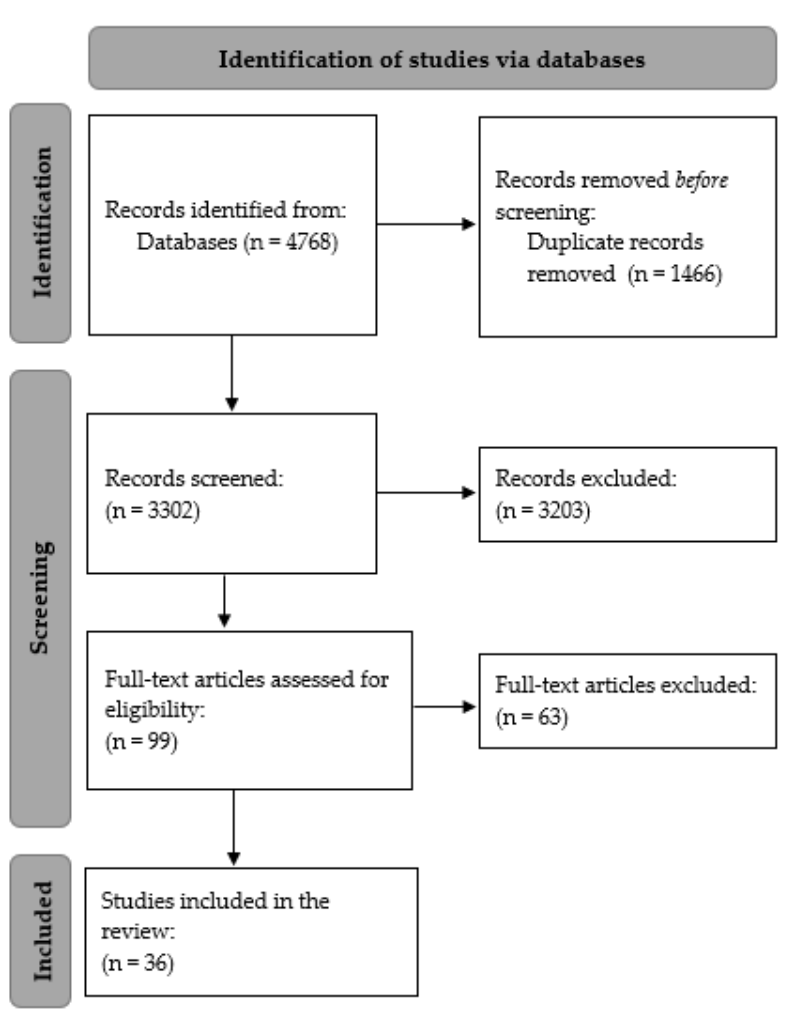
Figure 1. Flowchart of the study selection process for the Rapid Review .